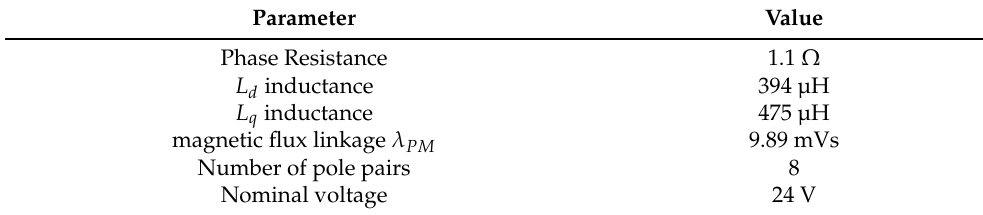
Table 1. Custom PMSM parameter list.